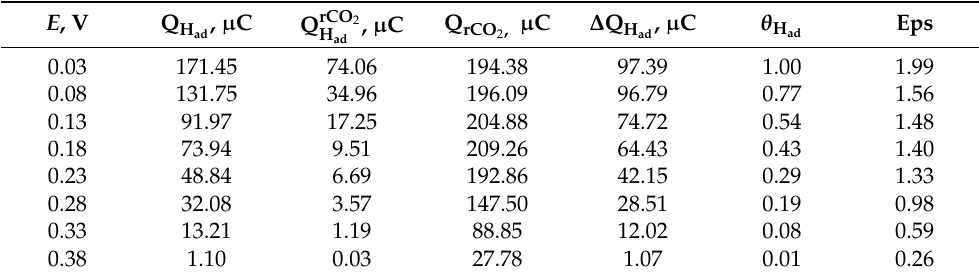
Table 1. Determination of eps in the CO 2 –H 2 O system on the (pc)Pt electrode according to the data presented in Figure